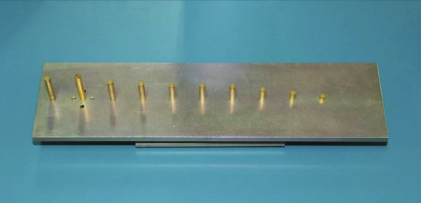
Figure 9: Photo for the 10-element monopole Yagi-Uda antenna mounted on a finite ground plane with size 𝐿 = 230 mm, 𝑊 = 60 mm.